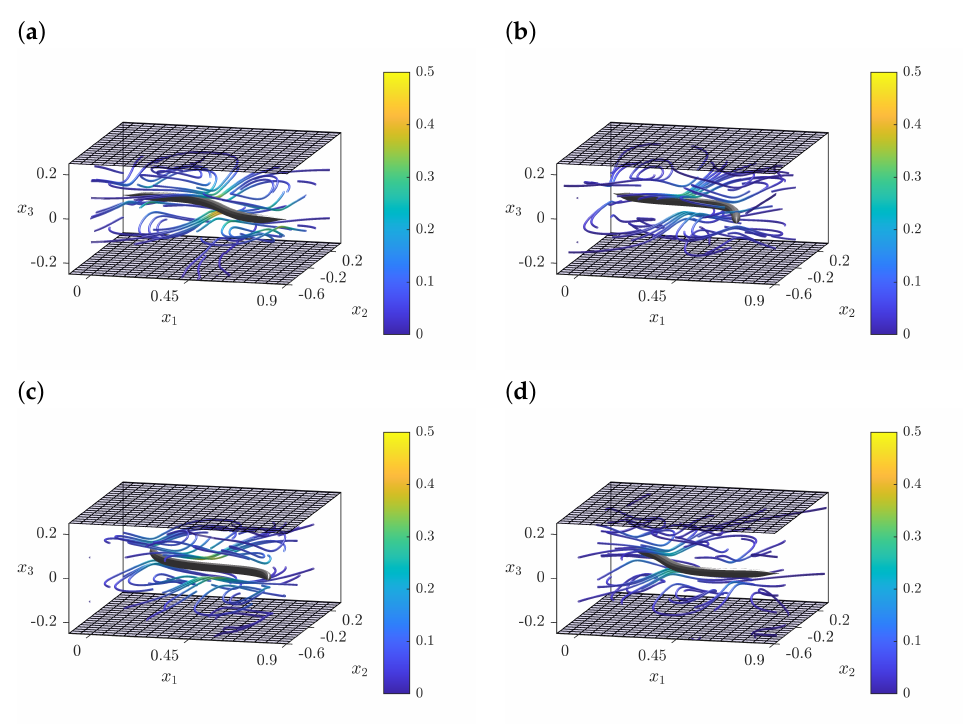
Figure 10. Undulating slender swimmer between solid boundaries, full boundary integral calculation, with maximum radius a 0 = 0.02. ( a – d ) instantaneous streamlines in the fluid at four approximately equally spaced intervals during the beat cycle.